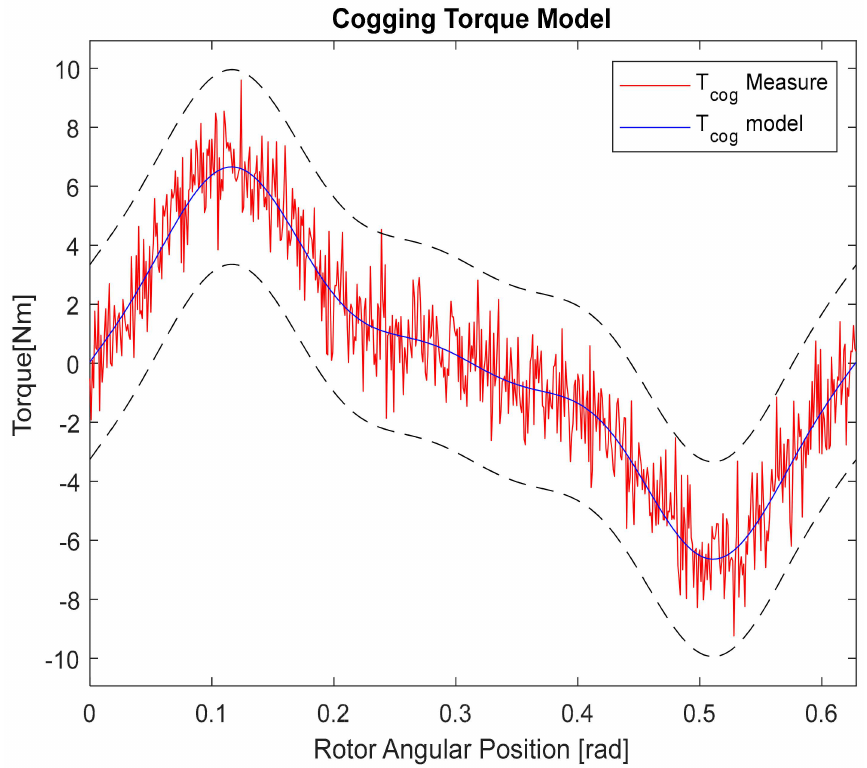
Figure 4. Comparison between the shape insert in the motor model (T cog Measure), used to design the controller, and the mathematical model (T cog